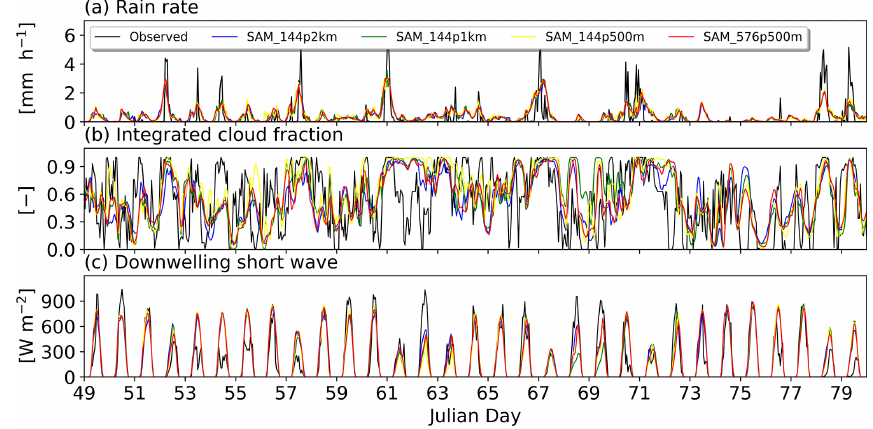
Figure 2. Time series of the domain average of the column-integrated cloud fraction (ranging from 0 for clear sky to 1 for overcast sky 1), precipitation rate (mmh − 1 ) and downward shortwave flux (Wm − 2 ) for the observations and the simulations with the SAM model for IOP1 (wet season). The black line represents the reference data (GoAmazon 2014/15), and the other colors represent the different horizontal resolutions used in the simulations